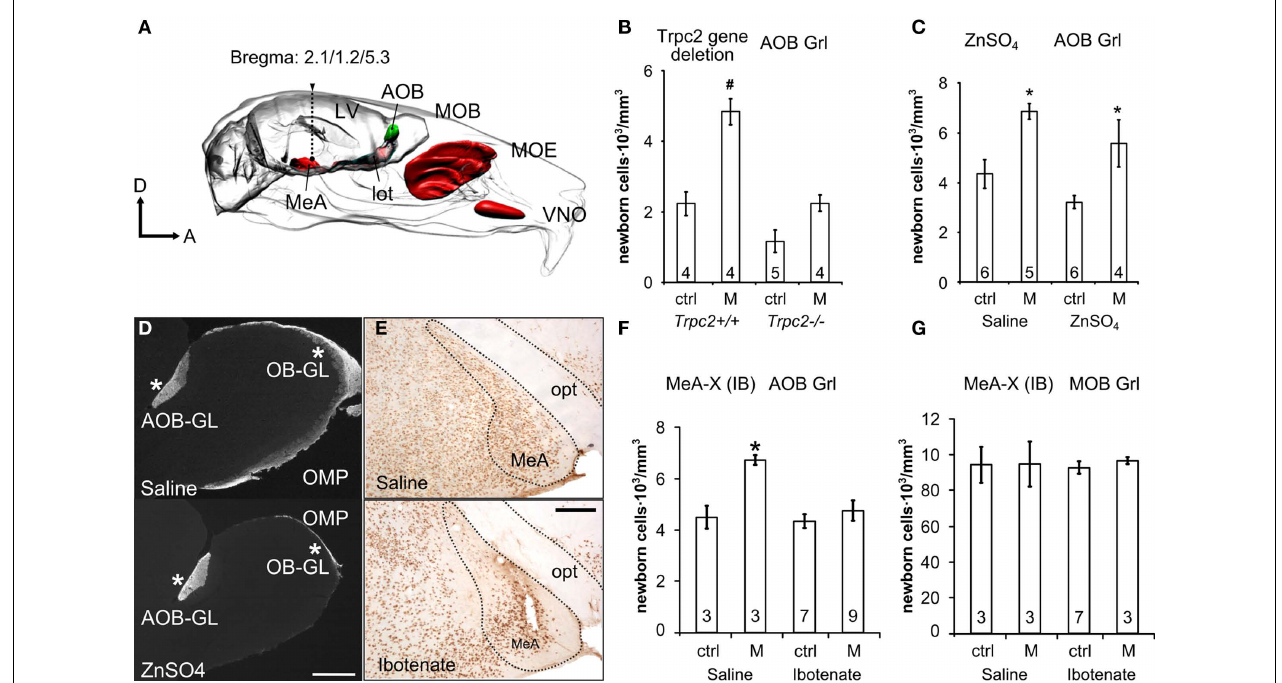
FIGURE 4 | Survival of newAOB granule cells depends on amygdala feedback activity induced by vomeronasal input. (A) Sites of functional impairment in the vomeronasal system: MeA, medial amygdala; MOE, main olfactory epithelium;VNO, vomeronasal organ (lot, lateral olfactory tract; LV, lateral ventricle). (B,C) Newborn 4-weeks-old AOB granule cells in trpc2 + / + , trpc2 − / − (B) and ZnSO 4 (C) mice exposed to male bedding 1week after BrdU injection. (D) Micrographs showing the loss of OMP expression in the MOB of ZnSO 4 -treated mice (lower), compared to saline-treated animals (upper). In both cases OMP labeling is present in the AOB glomerular layer (asterisks at the right) but absent in the MOB of the ZnSO 4 -treated mice (asterisk on the